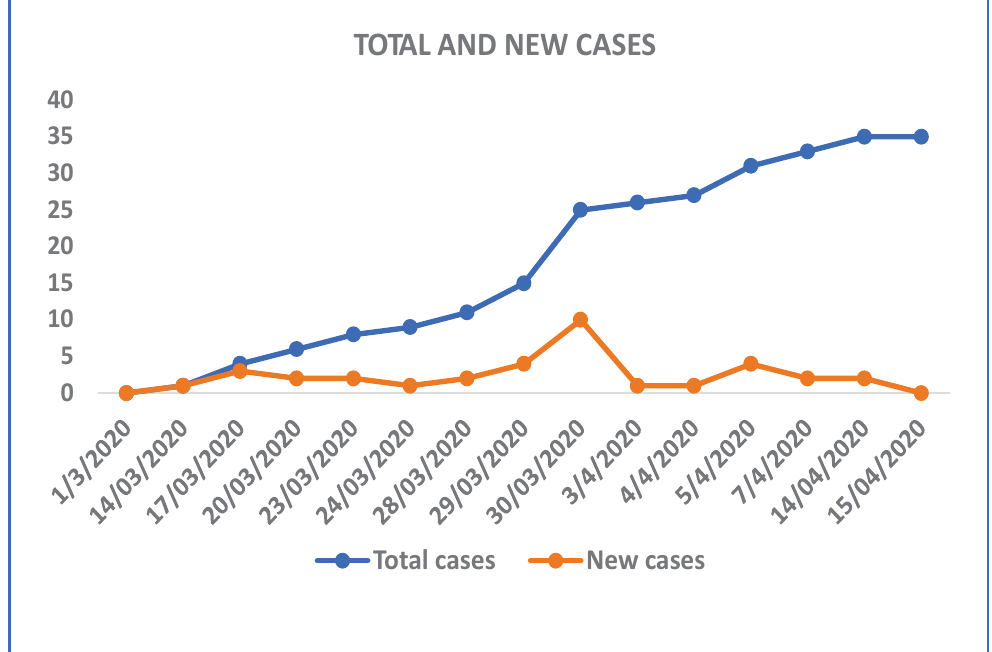
Figure 1: Number of total and new cases from 1 March to 15 April 2020 in Puttalam